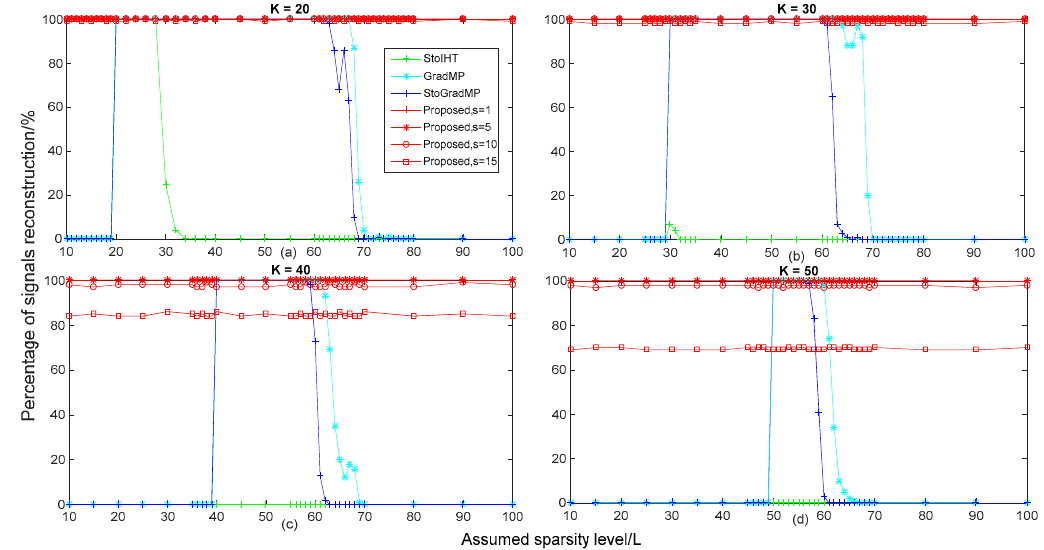
Figure 5. Reconstruction percentage of different algorithms with different sparsities in different real sparsity K conditions ( n = 400, s ∈ [ 1,5,10,15 ] , δ K = 0.1, and m = 170, L ∈ [ 10 100 ] , Gaussian